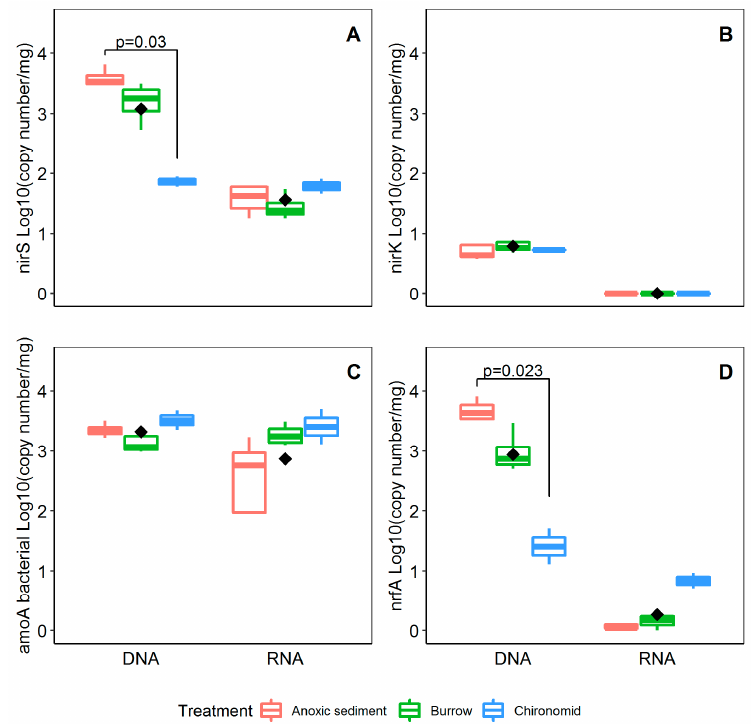
Figure 5. Abundance (DNA) and transcriptional activity (RNA) of the four analyzed target genes— nirS ( A ), nirK ( B ), amoA ( C ) and nrfA ( D )—assessed in the anoxic sediment, burrow wall sediment and chironomid larvae samples. Each boxplot represents the data range (whiskers), upper and lower quartiles (edges), median (horizontal line) and group mean (black diamond). The square brackets indicate significant pairwise difference between treatments (Kruskal–Wallis test followed by pairwise Dunn’s test).